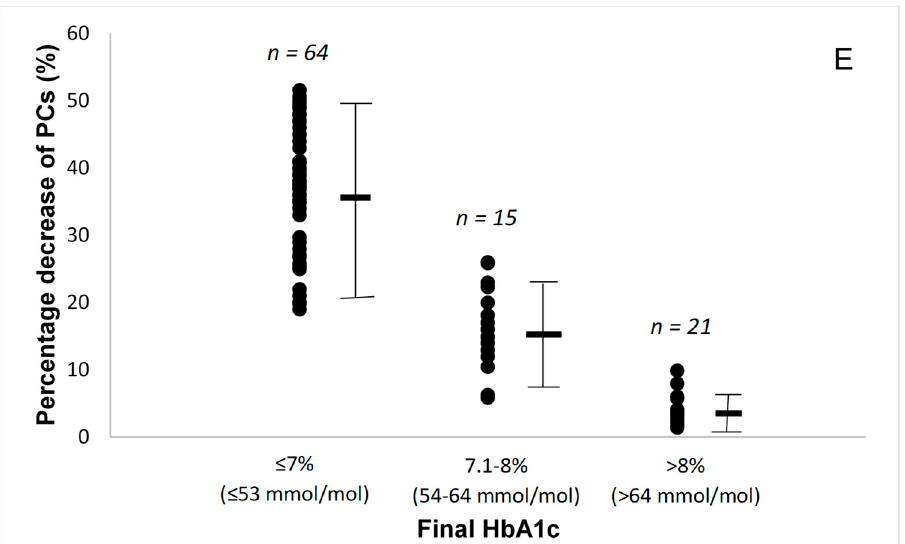
Figure 1. ( A ) Percentage changes in pulse wave velocity (PWV) by the final glycated haemoglobin (HbA1c) attained. ( B ) Percentage changes in global longitudinal strain (GLS) by the final glycated haemoglobin (HbA1c) attained. ( C ) Percentage changes in pulse wave velocity to global longitudinal strain ratio by the final glycated haemoglobin (HbA1c) attained. ( D ) Percentage changes in malondialdehyde (MDA) by the final glycated haemoglobin (HbA1c) attained. ( E ) Percentage changes in protein carbonyls (PCs) by the final glycated haemoglobin (HbA1c) attained. Lines are mean and SD.